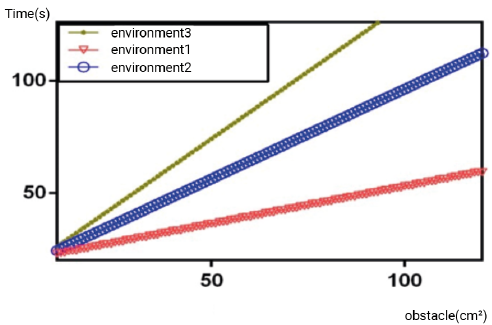
Figure 6. Increase in Target Finding Time by Obstacle Density. Algorithm 1 Robot distance